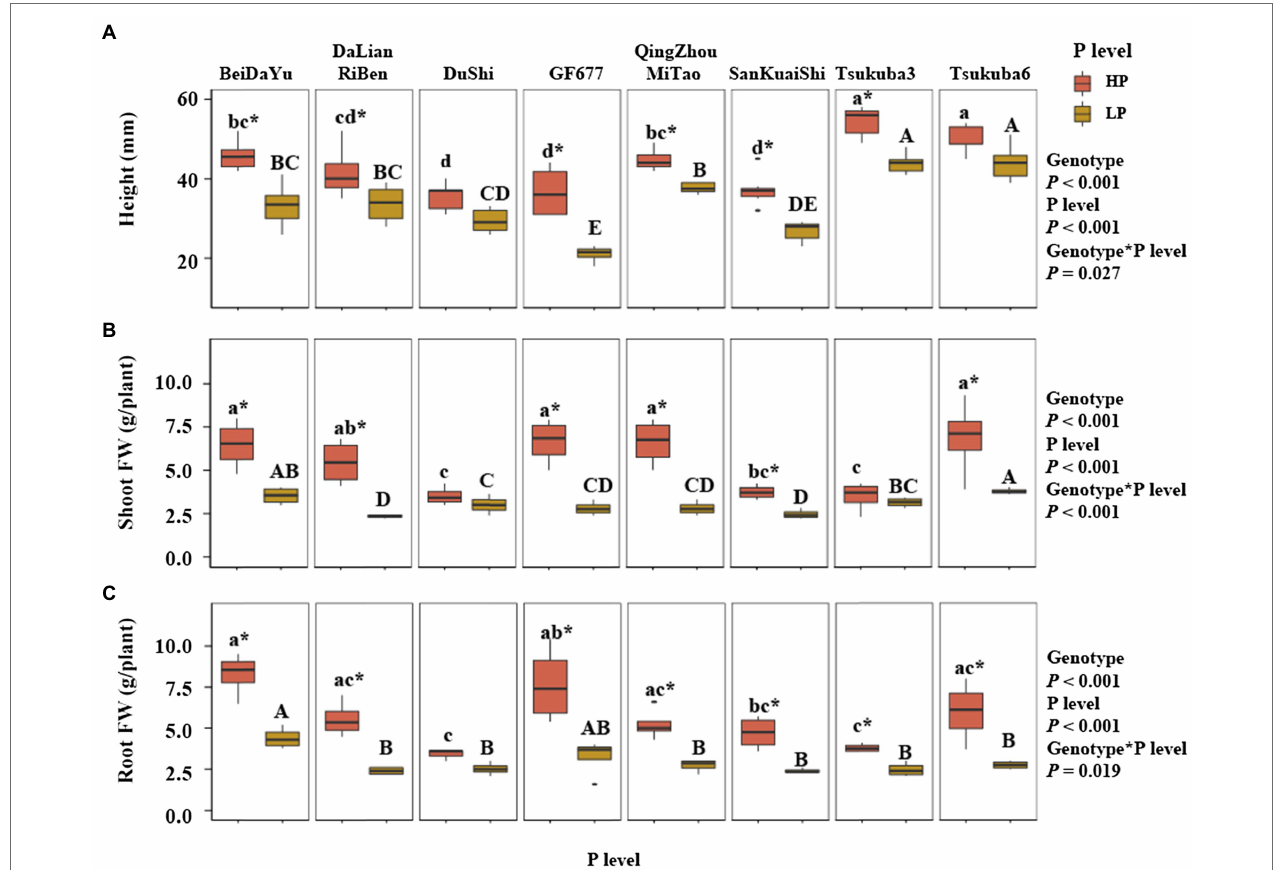
FIGURE 1 | Plant physiological traits at two levels of P supply. (A) Height, (B) Shoot FW (fresh weight), and (C) Root FW of eight peach rootstocks grown under HP or LP conditions. The statistical results are of two-way ANOVA testing for the effects of genotype and P level on the height, shoot FW, and root FW. Different lower- and upper-case letters indicate significantly differences ( p < 0.05) in the growth of eight peach rootstocks under HP and LP, respectively. * indicates significantly effects of the same peach rootstock species under two levels of phosphorus supply at p < 0.05